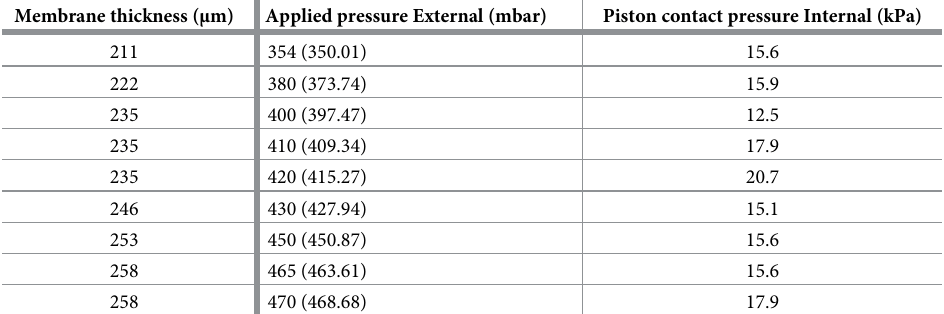
Table 1. Compression applied to cancer cells via fabricated different membrane thicknesses, showing externally applied pressures with sensor readings (in parentheses) from experiments and the predicted resulting internal maximum piston contact